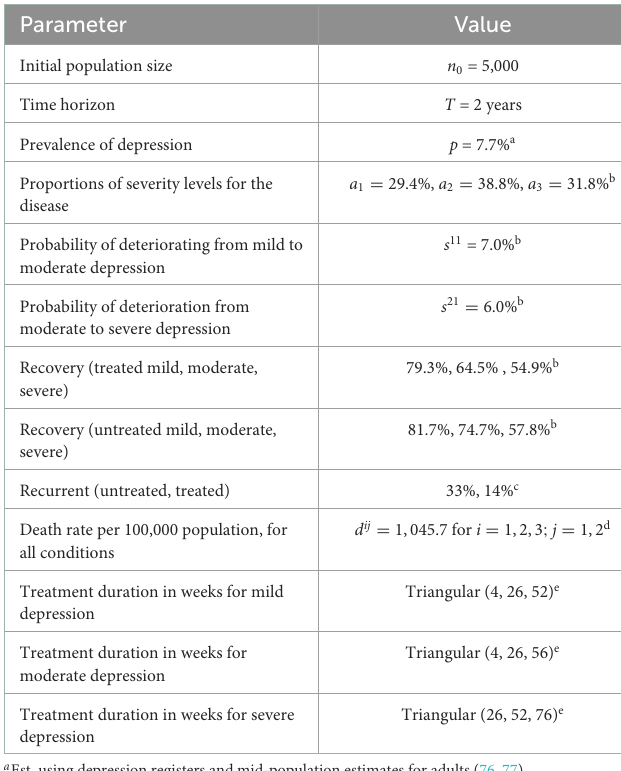
TABLE 1 Parameter values for multi-agent simulation model of disease progression.